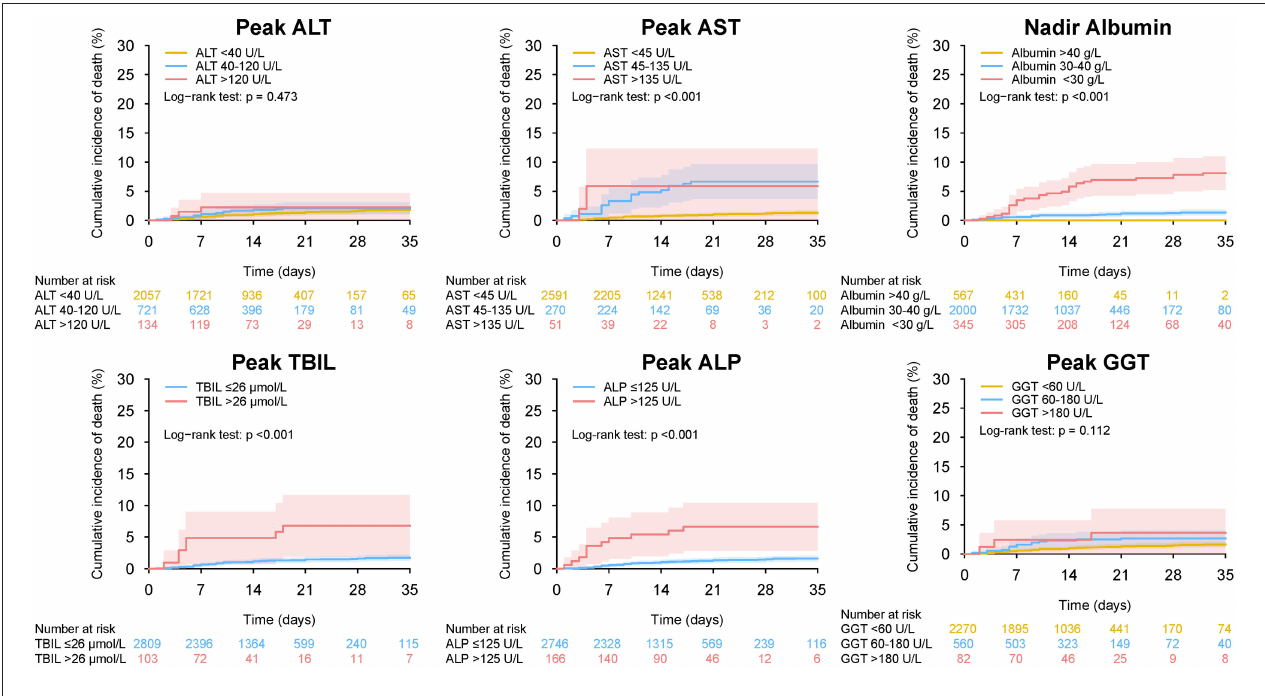
FIGURE 13 | Mortality during hospitalization in patients with different level of peak (nadir) liver function test in entire cohort. Cumulative incidence of death during hospitalization in patients with different level of peak ALT, peak AST, nadir albumin, peak TBIL, peak ALP, and peak GGT during hospitalization. ALT, alanine aminotransferase; AST, aspartate transaminase; ALP, alkaline phosphatase; GGT, gamma-glutamyltransferase; TBIL, total bilirubin